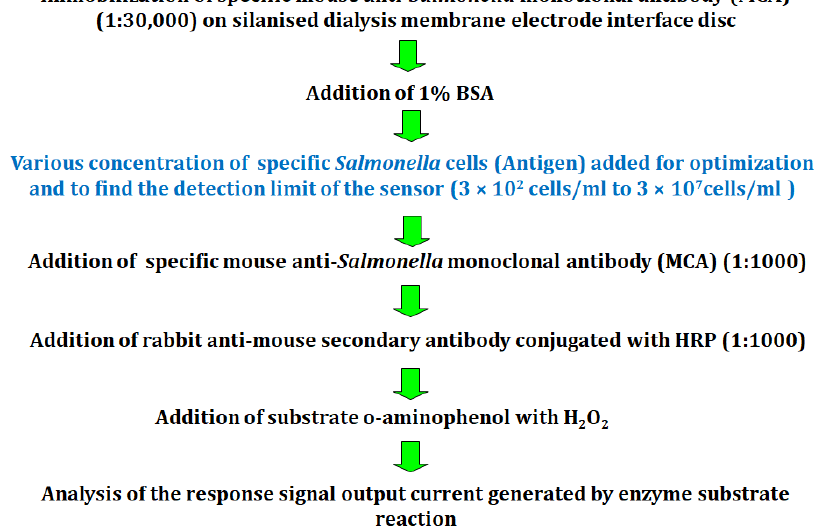
Figure 5. A schematic illustration depicting the optimization of Salmonella antigen cell concentration for Salmonella detection.